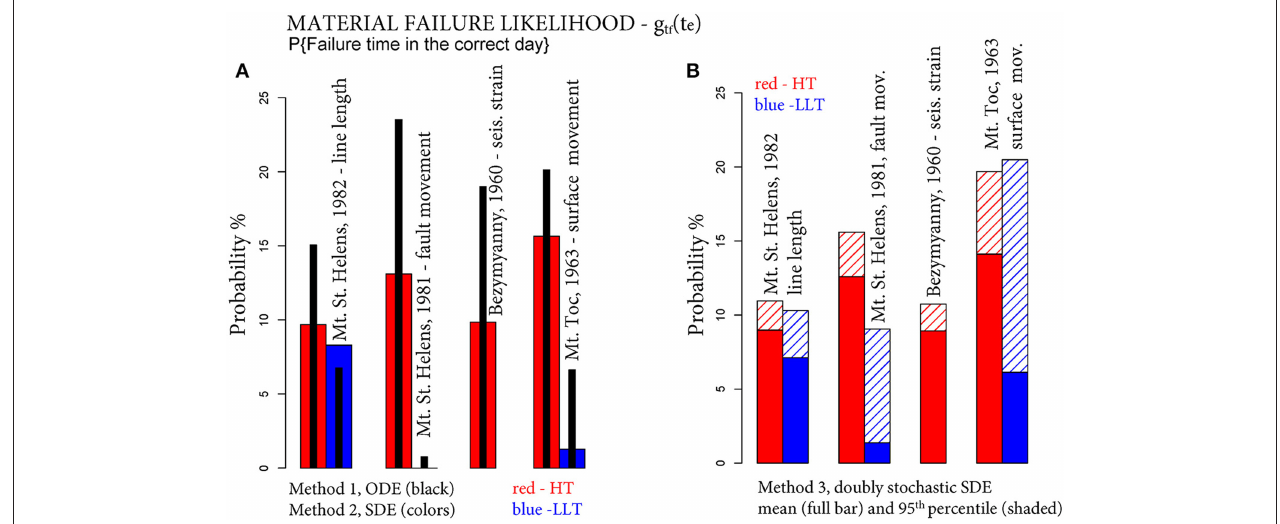
FIGURE 10 | Column plots of the likelihood g t ( t e ), i.e., the probability of failure time t f in the correct day t e . In (A) the black bars assume Method 1, the colored bars f Method 2. (B) Assumes Method 3, and the full bars are the mean values, and the shaded bars are the 95th percentile values of the likelihood.